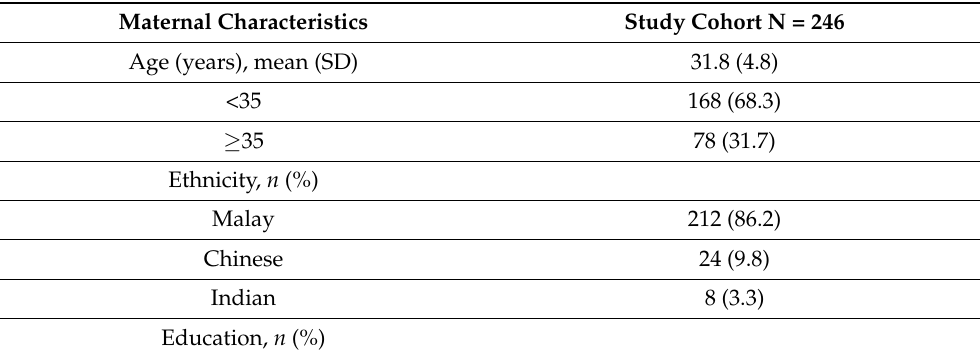
Table 1. Maternal demographics and clinical